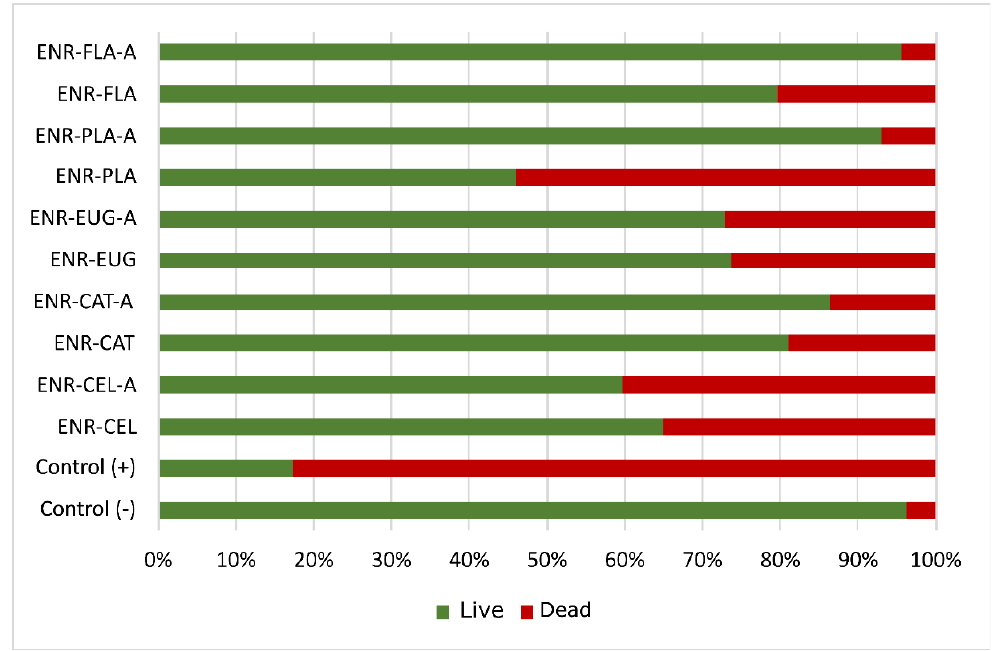
Figure 12. Results of antimicrobial tests performed for studied ENR-based composite samples. Letter “A” next to the sample symbol means “after aging”. “Dead” and “Live” refer to bacteria.